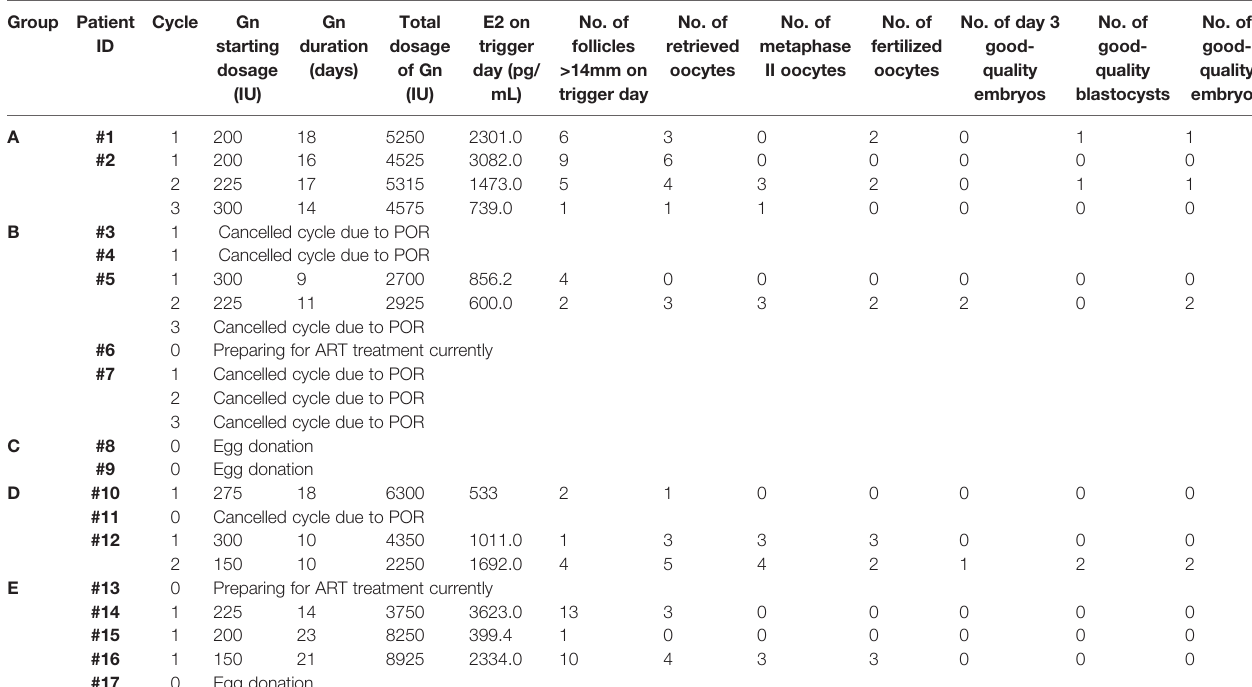
TABLE 4 | The ART characteristics and outcomes in BPES patients with different types of FOXL2 mutations. Group Patient